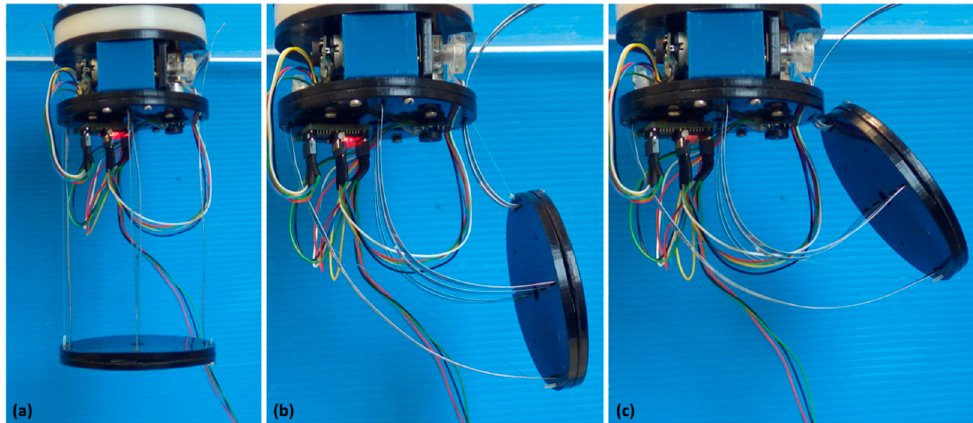
Figure 3. Assembled module at different bending angles. ( a ) 0° mode; ( b ) 90° mode; ( c ) 143° mode, where 143° represents the maximum bending angle achievable.